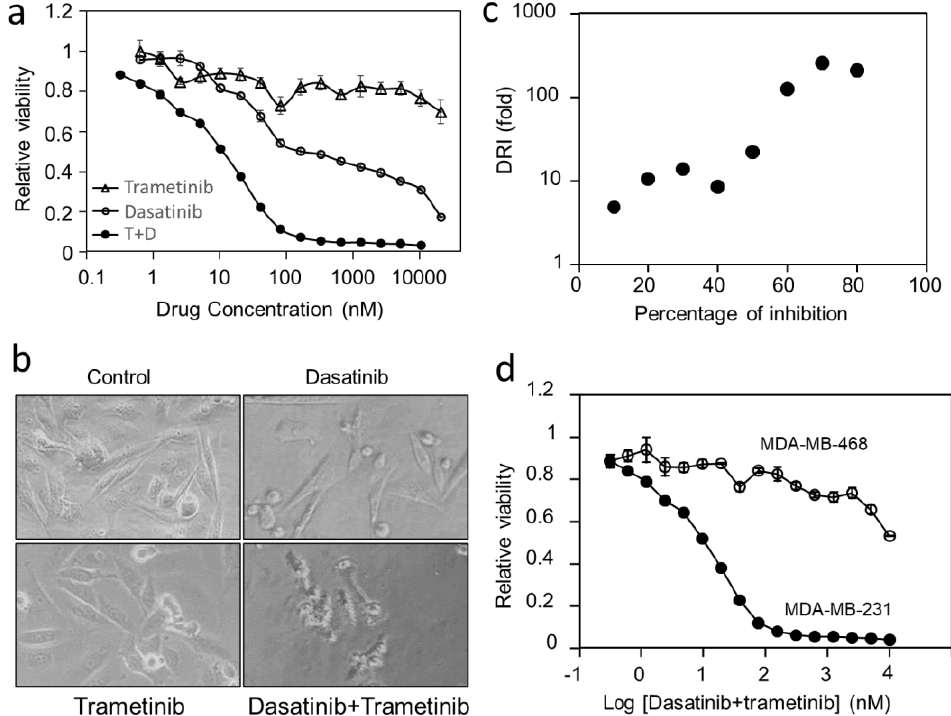
Figure 6. Effects of dasatinib, trametinib, and their combination on the viability and morphology of MDA-MB-231 cells. ( a ) Cell viability was determined after MDA-MB-231 cells were treated with dasatinib, trametinib, and their combination at equimolar concentrations for 48 h. ( b ) The relationship between the dose-reduction index (DRI) and the percentage of inhibition. ( c ) MDA-MB-231 cell morphology at the end of treatment with dasatinib, trametinib, and their combination (1 μM). ( d ) Comparison between MDA-MB-231 and MDA-MB-468 in the dose – response to dasatinib/trametinib combination.